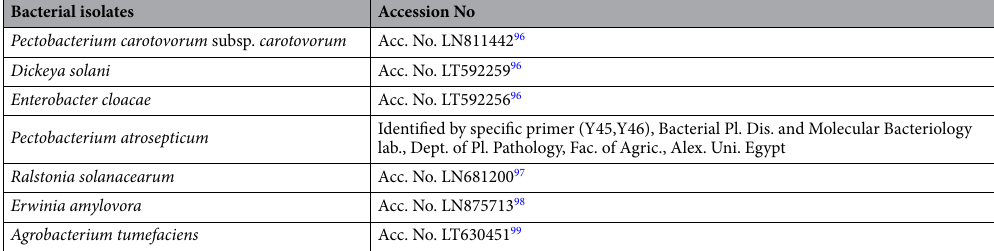
Table 7. Phytopathogenic bacterial isolates used in this